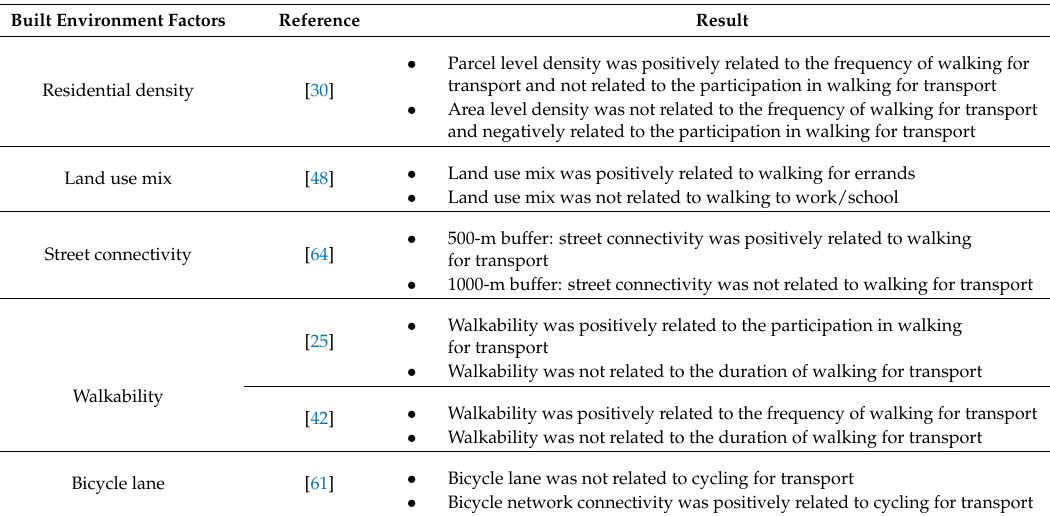
Table 9. Summary of inconsistent results from studies with different